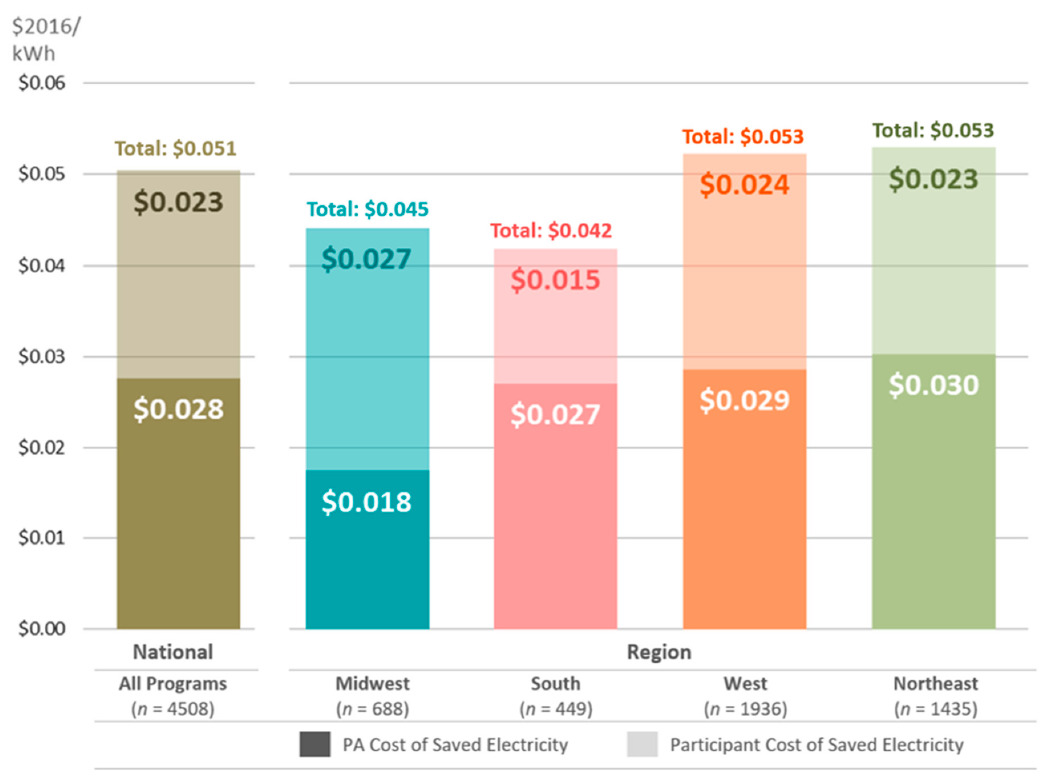
Figure 8. Total CSE by U.S. Census region: PA vs. participant costs (savings-weighted averages). 410